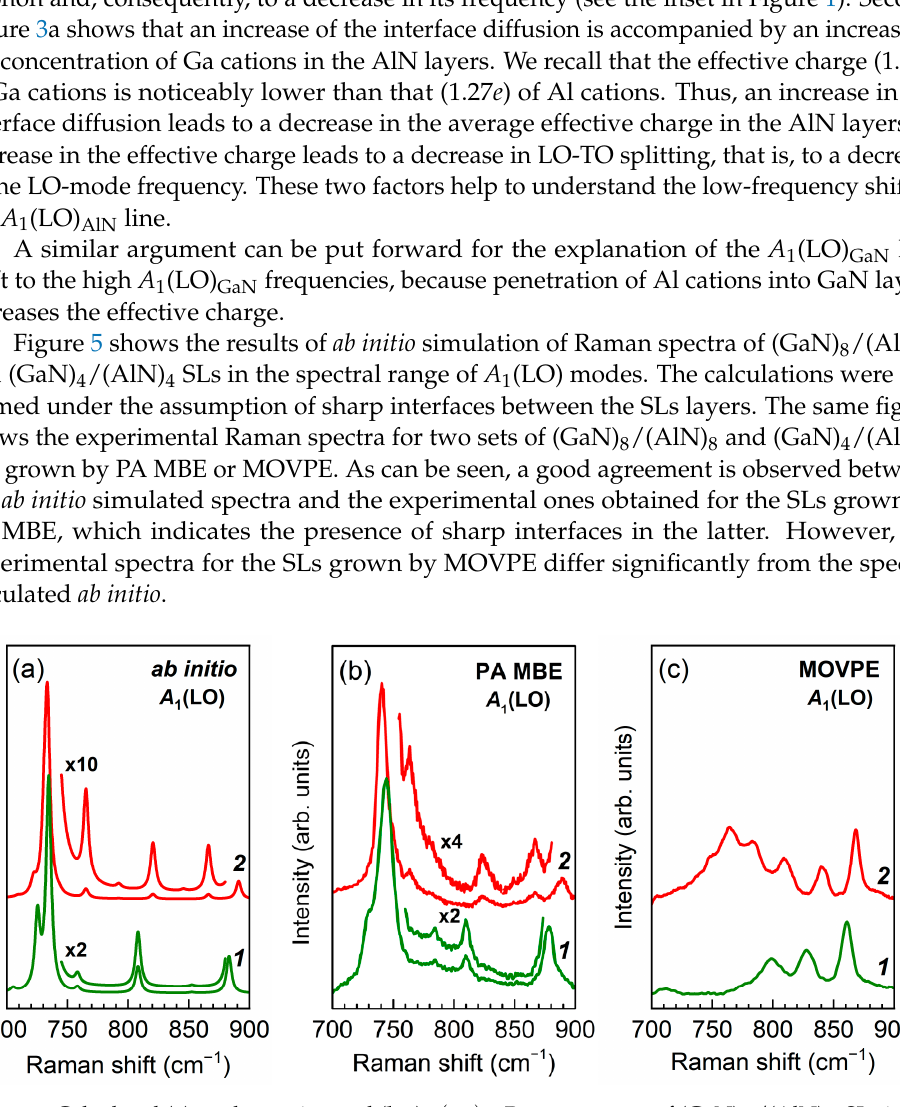
Figure 5. Calculated ( a ), and experimental ( b , c ) 𝑧(𝑥𝑥)𝑧̅ Raman spectra of (GaN) m /(AlN) m SLs in the range of A 1 (LO) modes: ( 1 ) m = 4, ( 2 ) m = 8, obtained upon subtracting the AlN buffer spectrum. The experimentally studied SLs were grown by PA MBE ( b ) and MOVPE ( c ).